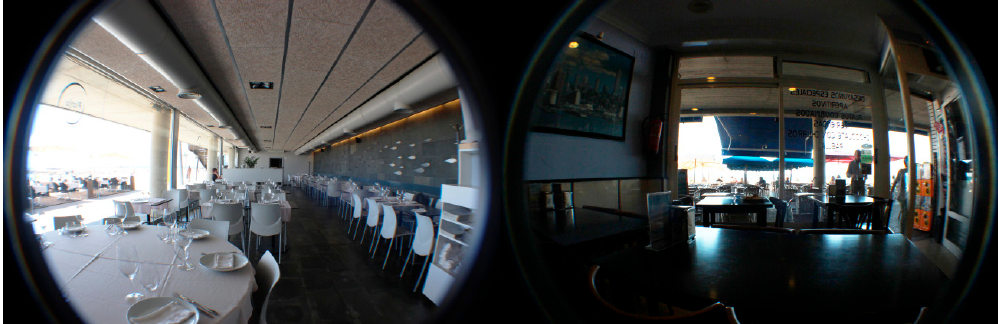
(Ca la Nuri). The picture on the right is a restaurant in Zarautz (Beach).